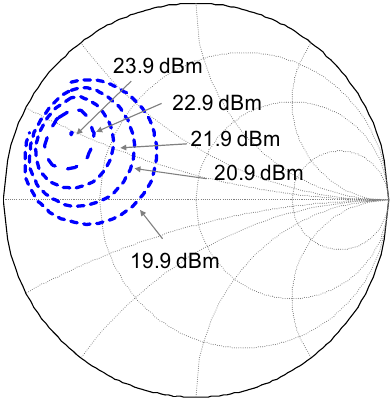
Figure 1. Load-pull contours for output power of 100 μ m-wide HEMT at 90 GHz.